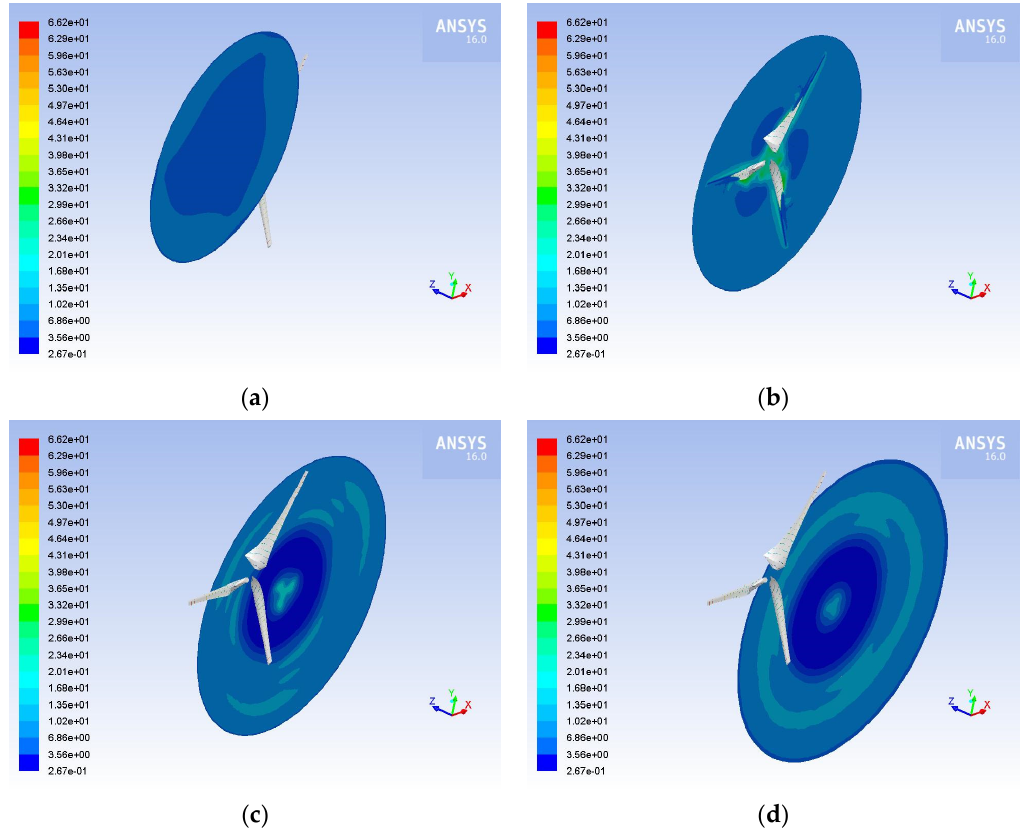
Figure 9. Contours of velocity at ( a ) − 15 m; ( b ) 0 m; ( c ) 15 m; ( d ) 30 m from the three-bladed HAWT rotor for hailstorm conditions and air velocity equal to 10 m·s − 1 .